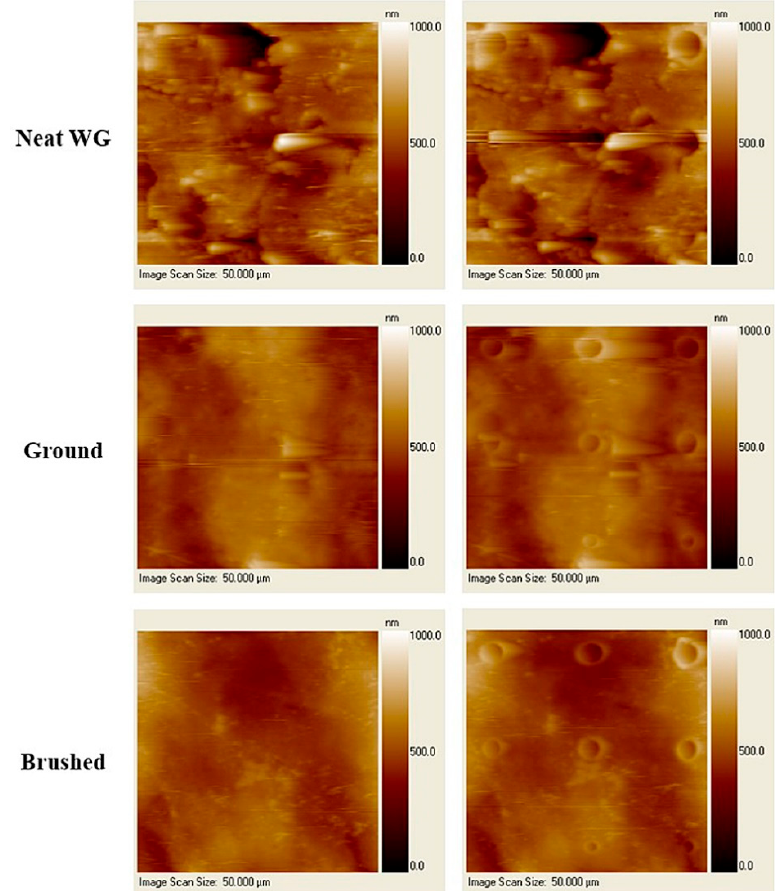
Figure 6. Nanoindentation regions (before and after indentation) measured top-down. The width of 50 µm in the images are the lateral dimension ( x - y axes). The color bar to the right of each image represents the height of the sample surfaces.